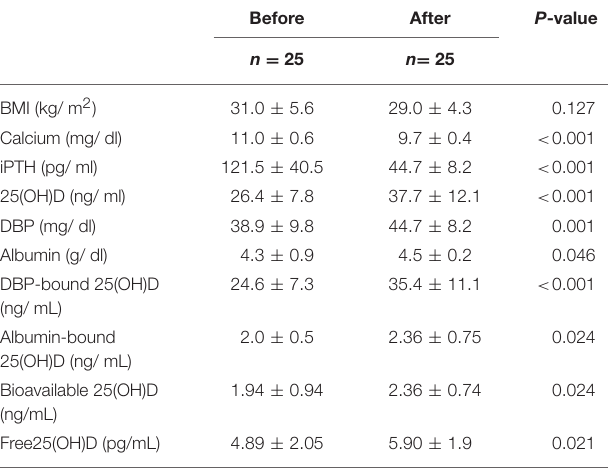
TABLE 3 | PHPT profile changes before and after